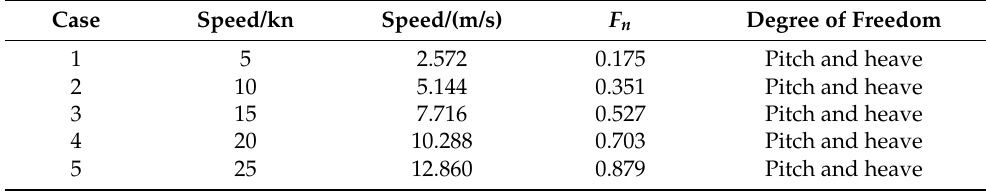
Table 4. Simulation conditions in calm water.